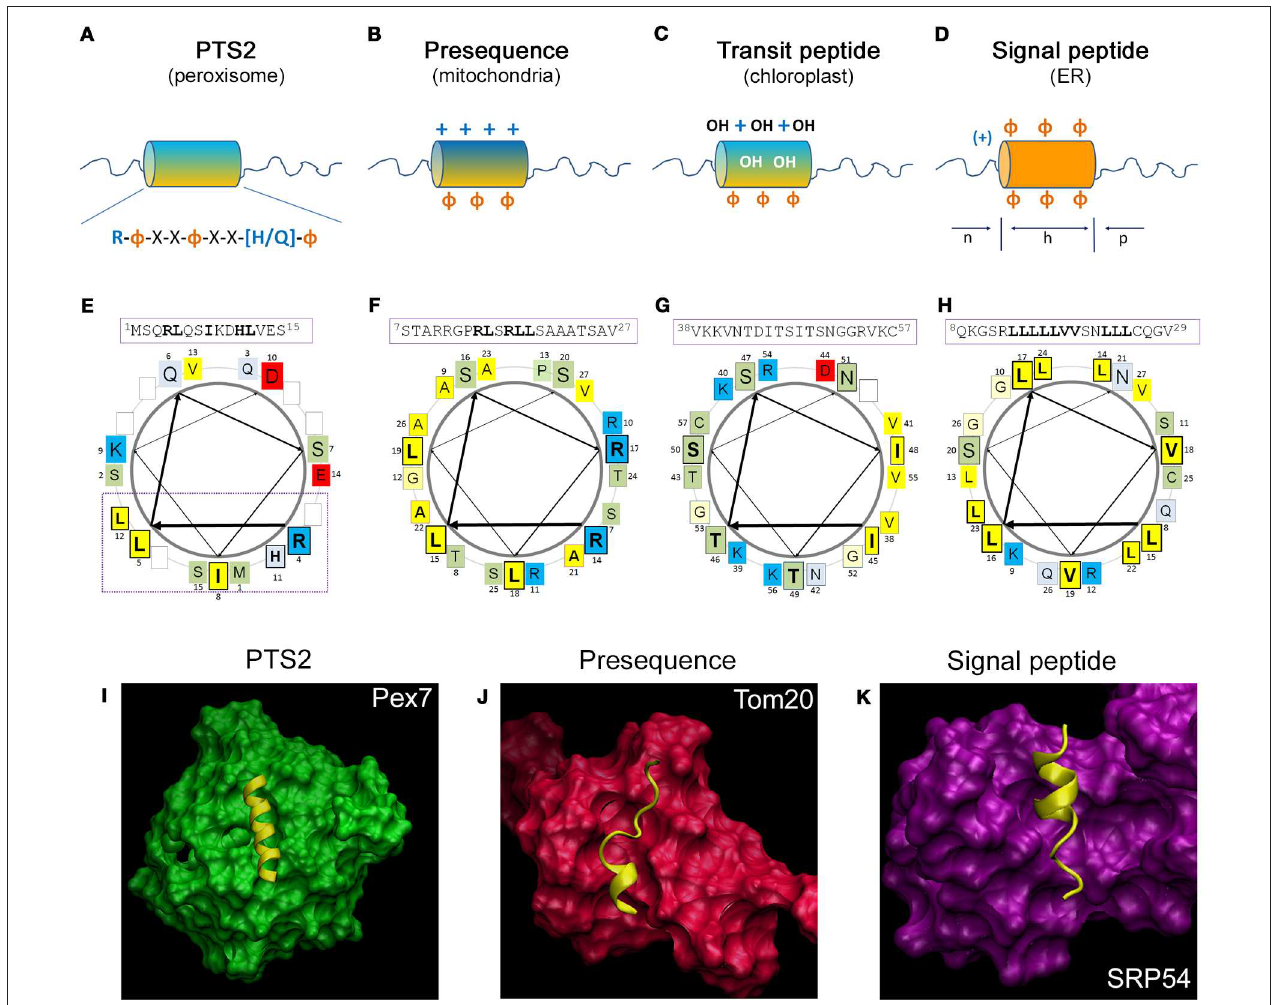
FIGURE 2 | Comparison of the structural properties of N-terminal targeting signals and their interaction with the receptor proteins. (A–D) Schematic representation of the N-terminal amino acid sequences encoding different targeting signals : (A) the peroxisomal PTS2 forming an α -helical domain encoding the consensus sequence, which is followed by an unstructured sequence element; (B) the mitochondrial presequence is enriched for positive charges and forms an amphipathic α -helical domain, (C) the chloroplast transit peptide sequence is enriched in hydroxylated amino acids; and (D) the signal peptide for the ER is composed of a positively charged (n)-domain, a hydrophobic (h)-domain, and a polar (p)-domain. +, positive charges; OH, hydroxylated residues; 8 , hydrophobic residues; orange, hydrophobic side; blue, hydrophilic side of the helix. (E–H) Helical wheel depiction of typical N-terminal targeting signals : (E) the PTS2 of yeast thiolase ( Sc Fox3), (F) the presequence of rat aldehyde dehydrogenase ( Rn Aldh2), (G) the transit peptide of pea ribulose-1,5-bisphosphate carboxylase/oxygenase small subunit ( Ps prSSU), and (H) the signal peptide of bovine preprolactin ( Bt PRL). The amino acid sequences depicted in the α -helical wheel projections are indicated above using the numbering of the primary sequence; amino acids of the central turn are indicated by larger letters; residues of the PTS2 consensus sequence, residues of the presequence interacting with Tom20, the hydroxylated residues of the transit peptide and the hydrophobic patch of the signal sequence are indicated bold and boxed. The color code for the physical properties of the residues is as follows: acidic red, basic blue, hydrophobic yellow, polar basic bluish gray and polar neutral green. The arrows indicate the progression of the amino acid sequence within the α -helical wheel. (I–K) 3D structure of the receptor protein and the α -helix of the targeting signal: (I) the N-terminus of yeast Fox3 involving a PTS2 (yellow) together with the receptor protein Pex7 (green), (J) the presequence of rat Aldh2 (yellow) together with the soluble domain of Tom20 (red), (K) the leader peptide of yeast dipeptidylpeptidase B (yellow) together with the cargo binding domain of archeal Srp54. The structures have been generated by the program visual molecular dynamics (VMD) (Humphrey et al., 1996) based on the datasets PDB:3W15 (Pan et al., 2013) (I), PDB:1OM2 (Abe et al., 2000) (J) and PDB:3KL4 (Janda et al., 2010) (K)